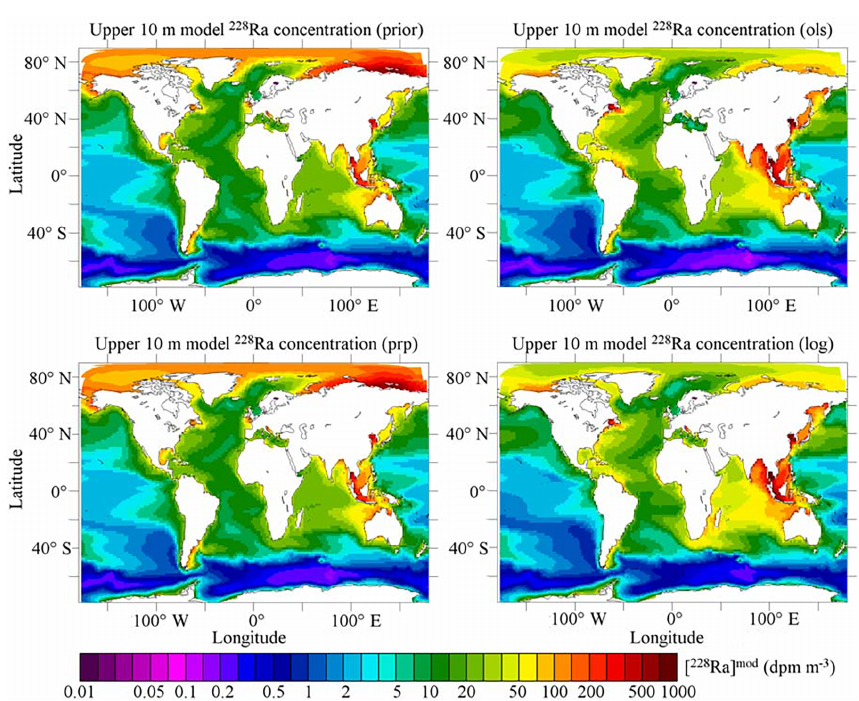
Figure 4. Model surface 228 Ra concentration after minimization of three cost functions. Prior estimate is shown for comparison.